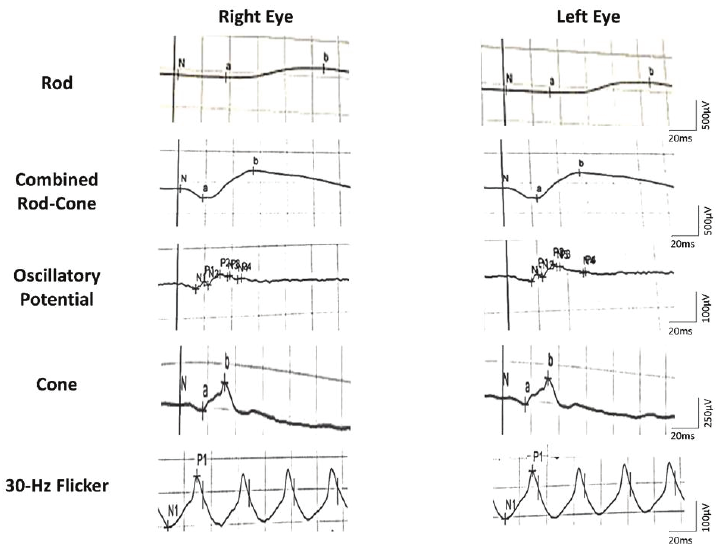
Figure 4. Full-field electroretinography of both eyes detected a reduction in amplitude of rod response and also a smaller reduction in combined rod-cone, oscillatory potential, and cone responses. The amplitude of 30-Hz Flicker responses in both eyes was